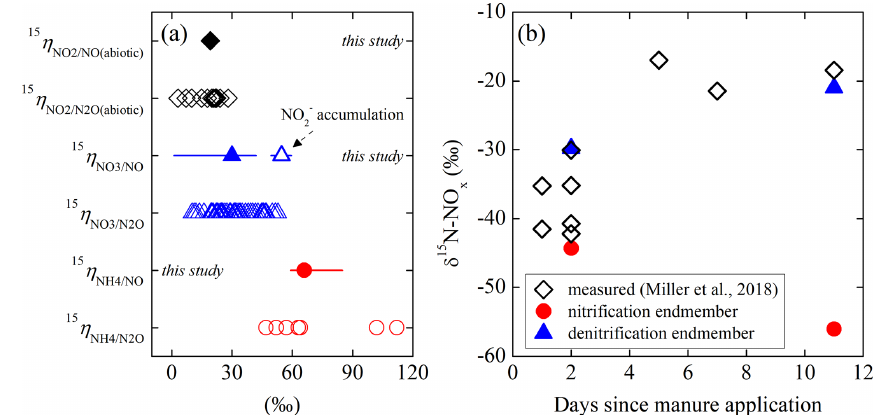
Figure 12. (a) Comparison of net isotope effects for NO production estimated in this study to net isotope effects for N 2 O production reported in the literature. (b) Comparison of in situ δ 15 N of NO x emission from a manure-fertilized soil (reported by Miller et al., 2018) to nitrification and denitrification δ 15 N-NO end-members derived using the estimated net isotope effects for NO production in the oxic and hypoxic